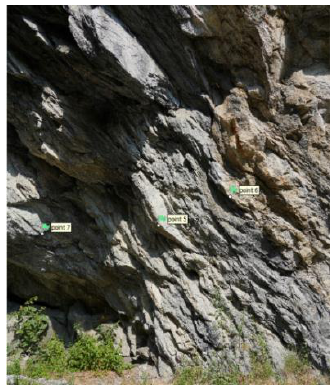
Figure 10. Examples of natural markers used for georeferencing the specific DTMs.